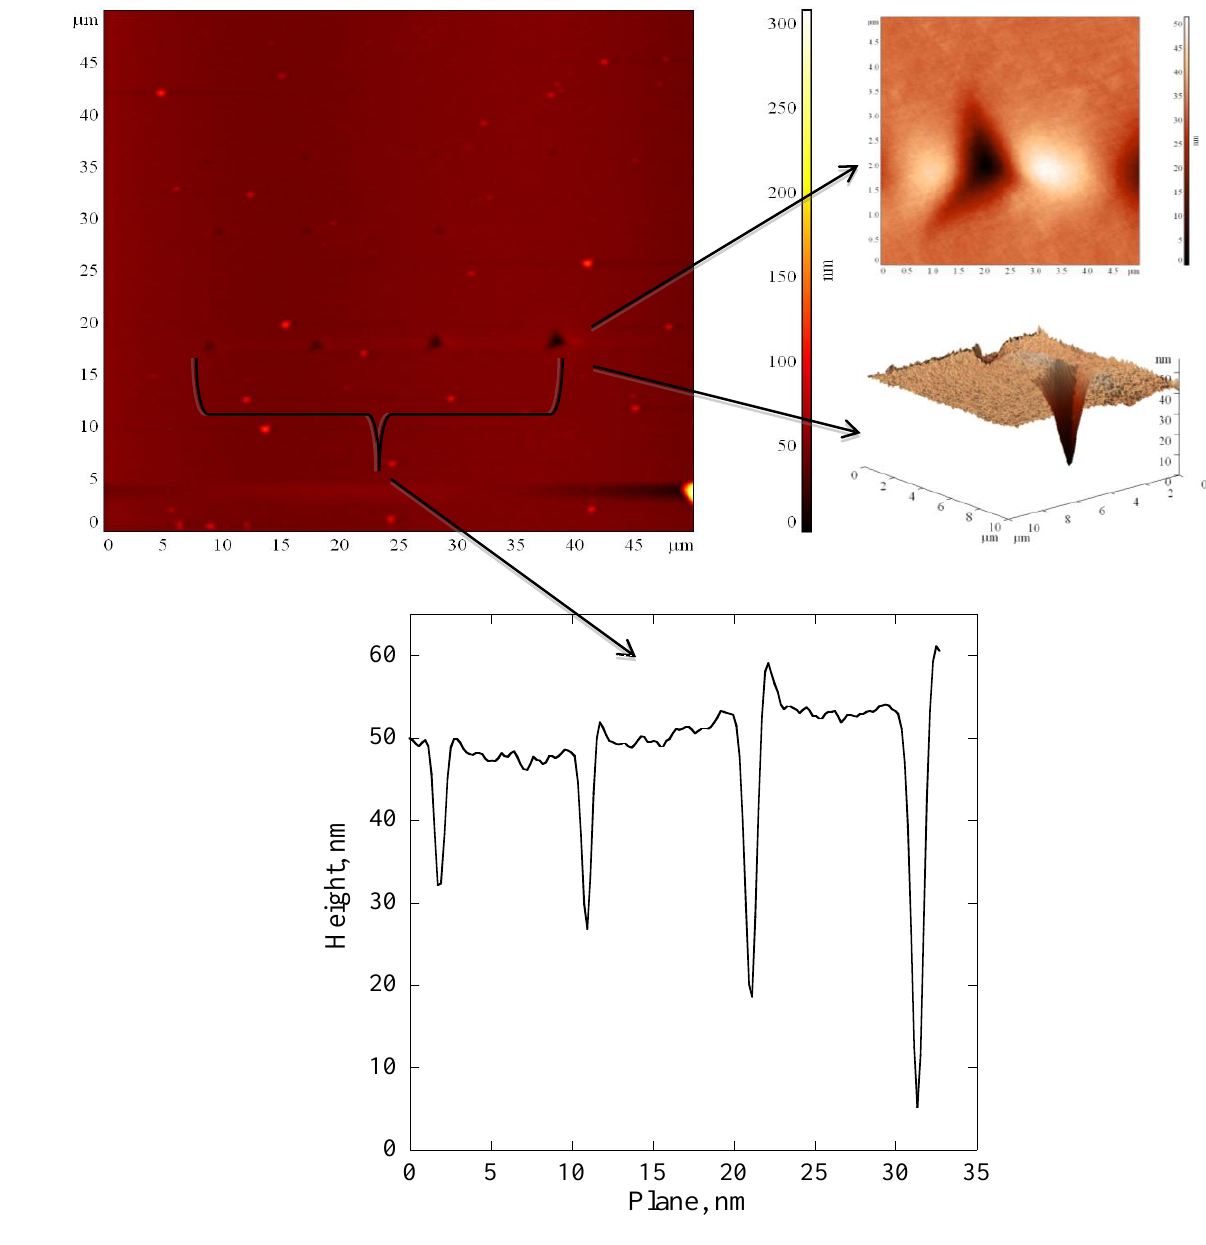
Figure 7. Typical AFM image of plastic impressions remaining in pp–GT sample fabricated at 75 W after indentation under different load